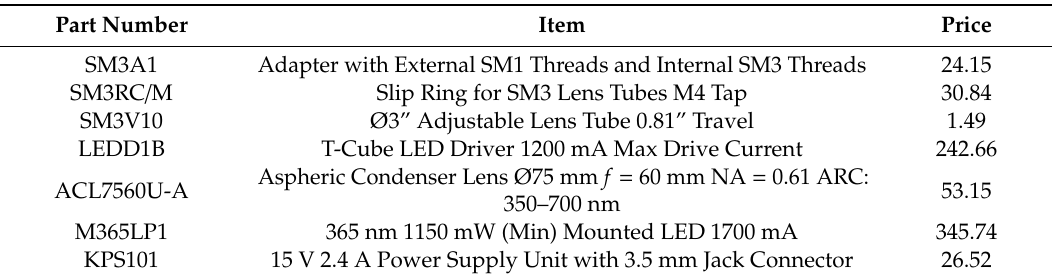
Table A1. Photolithography set-up, bill of materials from Thorlabs Inc.